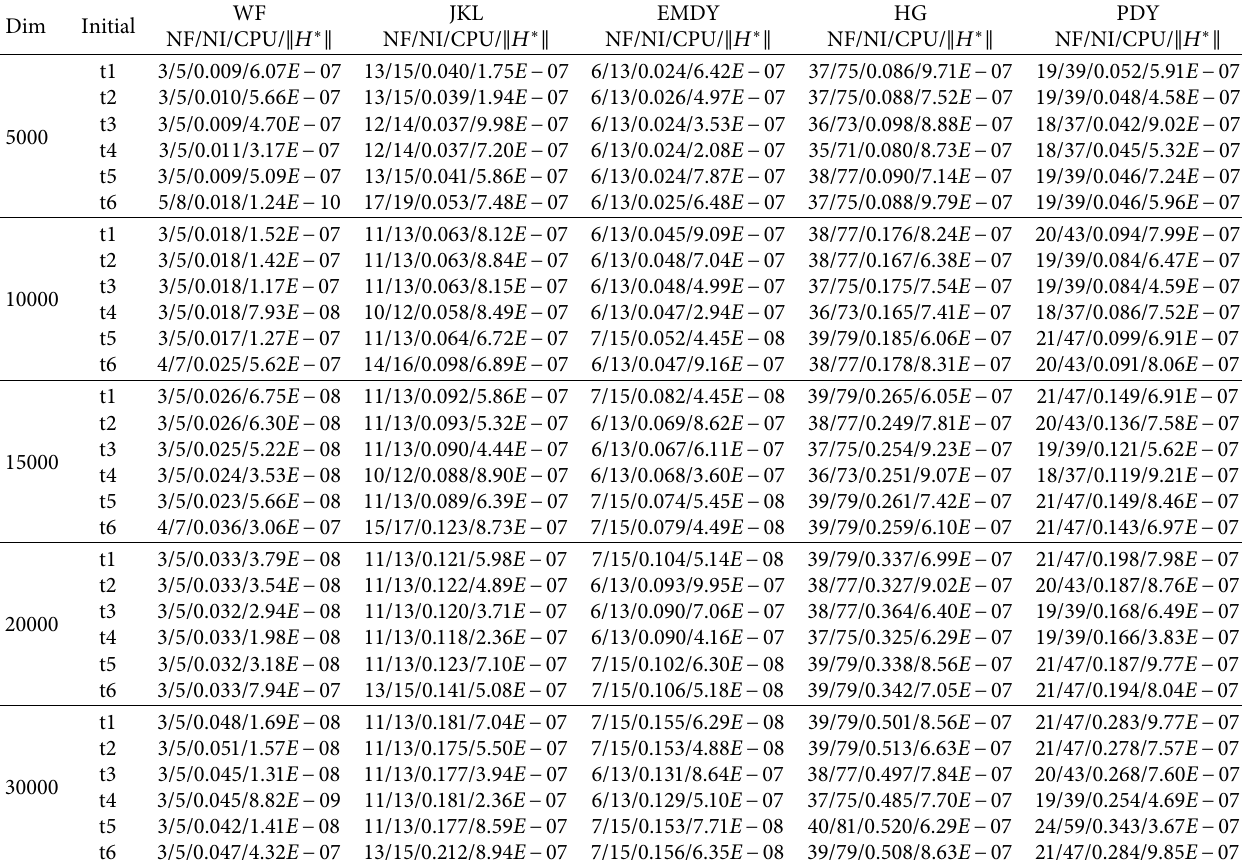
Table 5: Numerical results on problem 5.